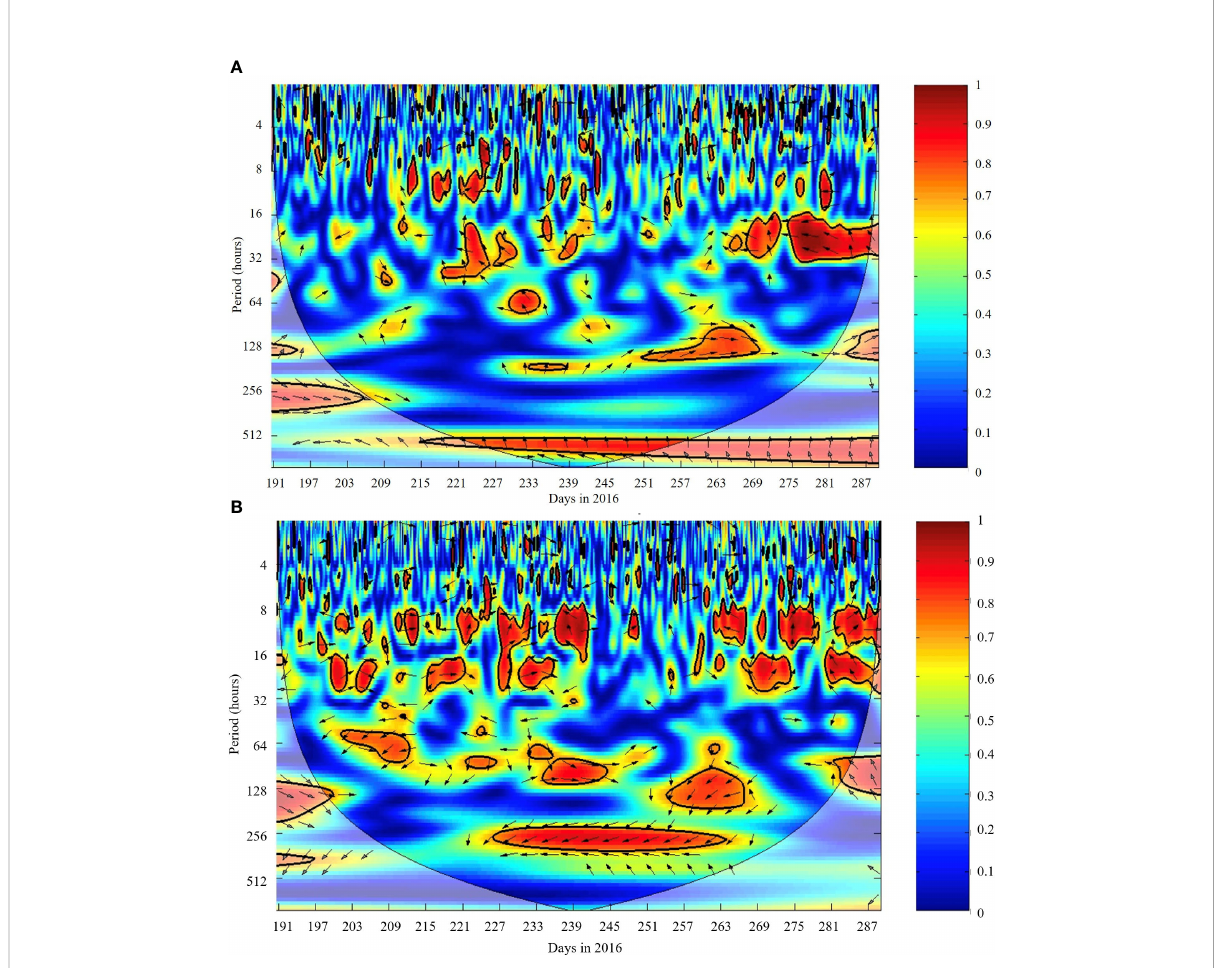
FIGURE 5 Cross-wavelet coherence of CO 2 fl uxes and windspeed (A) and CO 2 fl uxes and water pressure anomaly (B) for the period spanning from July up to November 2016. The contours are for variance units. The 5% signi fi cance level against red noise is shown as a thick contour (cone of in fl uence). Blurred regions indicate values outside the cone of in fl uence. The vectors indicate the relative phase between the variables. The horizontal scale represents the Julian days in July-November 2016